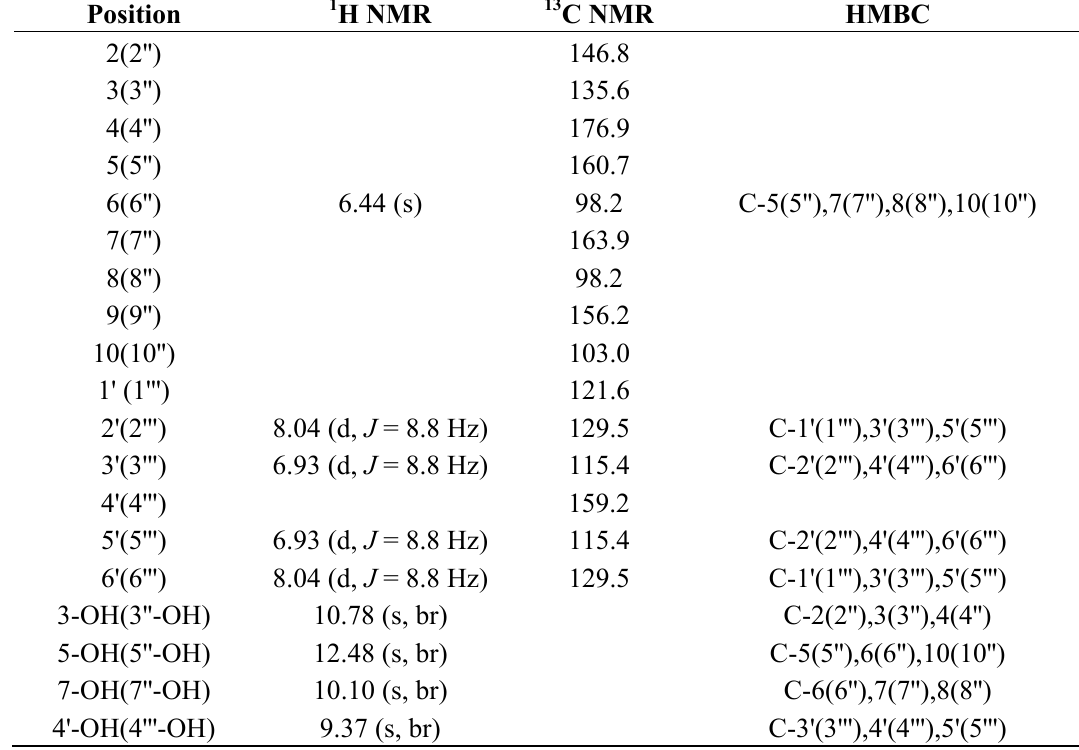
Table 1. 1 H NMR, 13 C NMR and HMBC data of the biflavonoid from shells of ). Camellia oleifera (DMSO-d 6